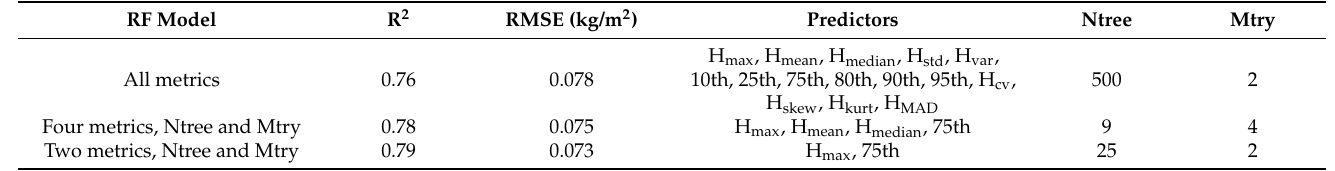
Figure 6. Relationship between the measured and predicted AGB values. Table 3. R 2 and RMSE result of various predictors, Ntree, and Mtry